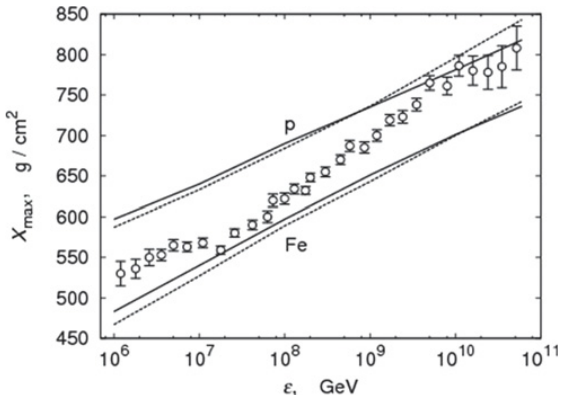
Figure 4. Dependence of X max on energy. Lines are calculated values for proton and iron nuclei.